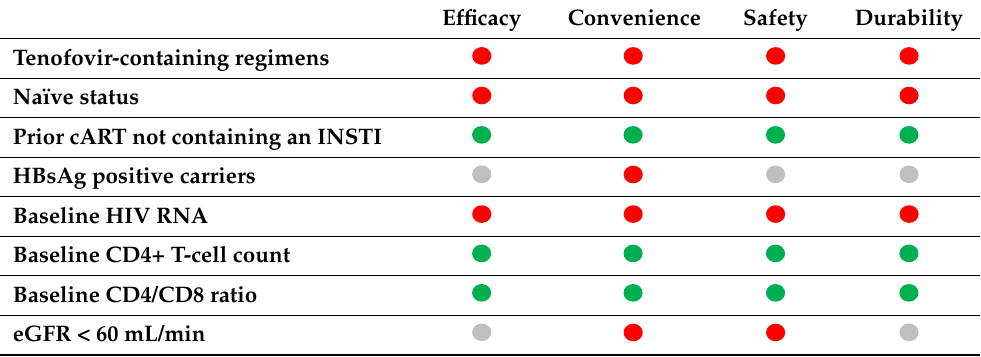
mated Glomerular Filtration Rate.